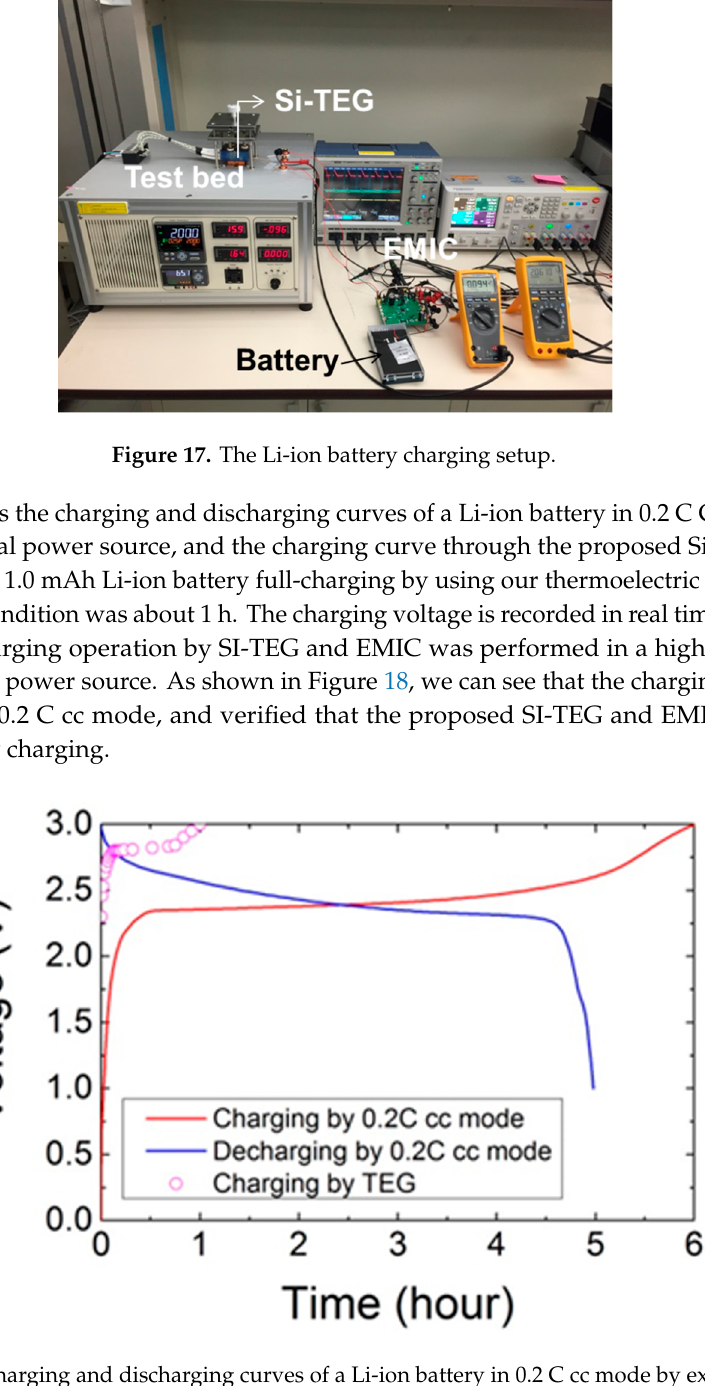
Figure 18. The charging and discharging curves of a Li-ion battery in 0.2 C cc mode by external power source and the charging curve through the proposed Si-TEG and EMIC.